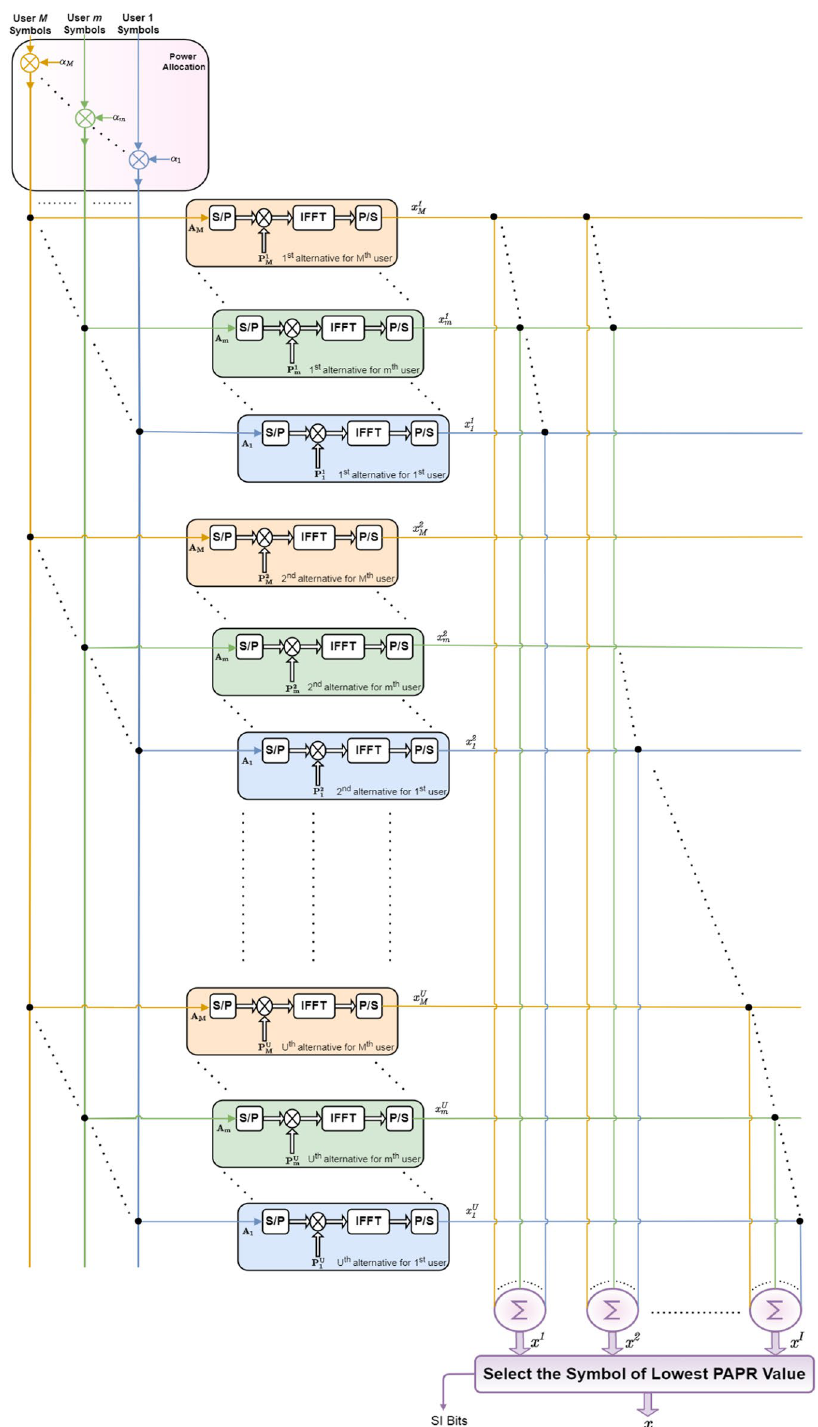
Fig. 4 Block diagram of the proposed SLM technique for DL OFDM-NOMA